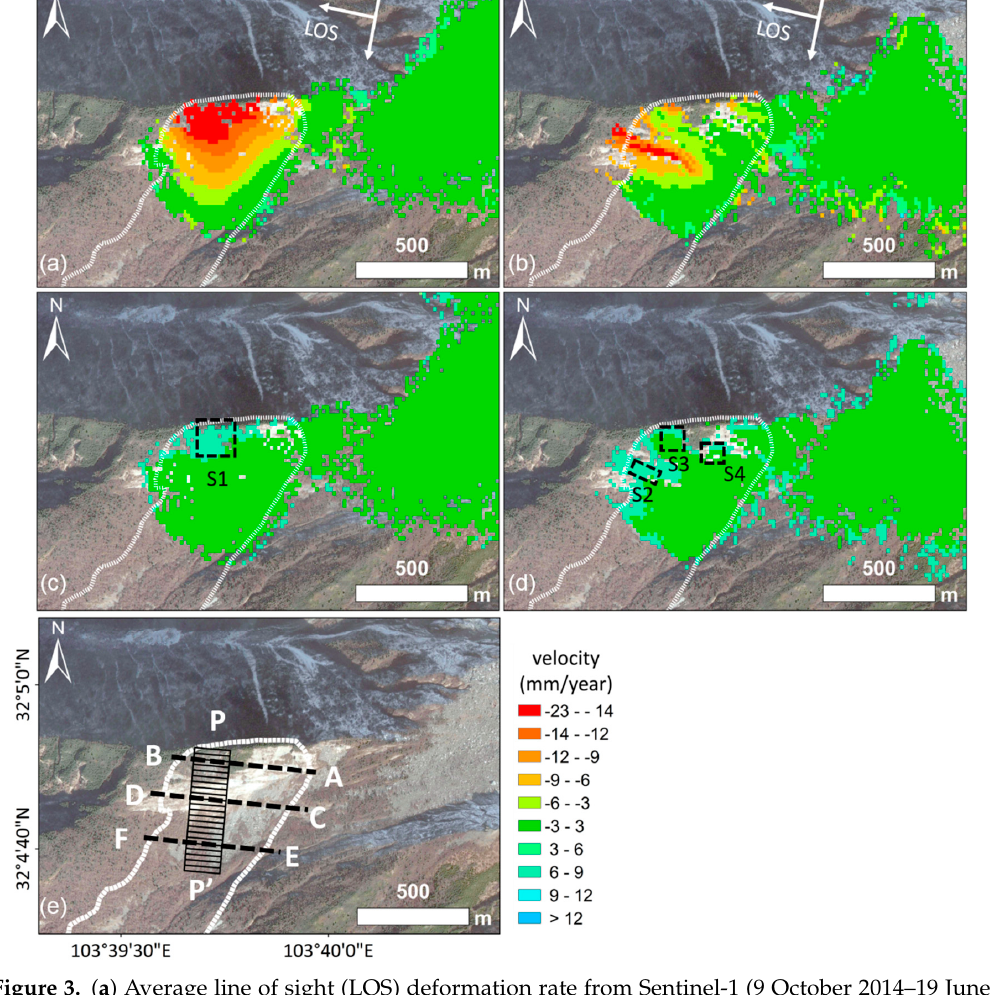
Figure 3. ( a ) Average line of sight (LOS) deformation rate from Sentinel-1 (9 October 2014–19 June 2017). The white line represents the failure boundary of the landslide in all panels. ( b ) Average LOS deformation rate from Envisat (16 June 2008–26 July 2010). ( c ) Standard deviation of the phase rate from the Sentinel-1 interferograms. ( d ) Standard deviation of the phase rate from the Envisat interferograms. The time–series deformation measurements in the rectangular regions S1, S2, S3 and S4 were extracted for further analysis in Sections 4.1 and 4.3. ( e ) Google-earth image of the landslide. PP’ was along the average downslope direction. The dashed lines AB, CD and EF denote the profile